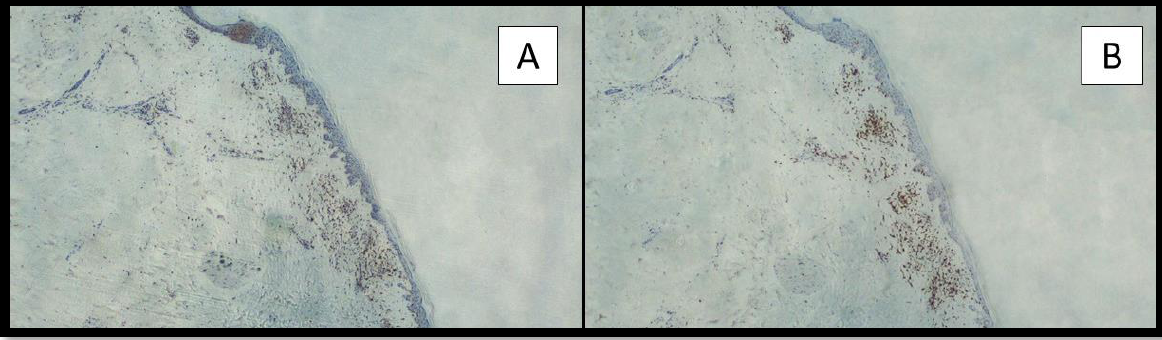
Figure 6. Immunostaining for CD4 (A) and CD8 (B) T-lymphocytes: note the similar quantity of T- cells and distribution at perivascular and peri-adnexal sites. (Immunohistochemistry; Original Mag- nification 4×).